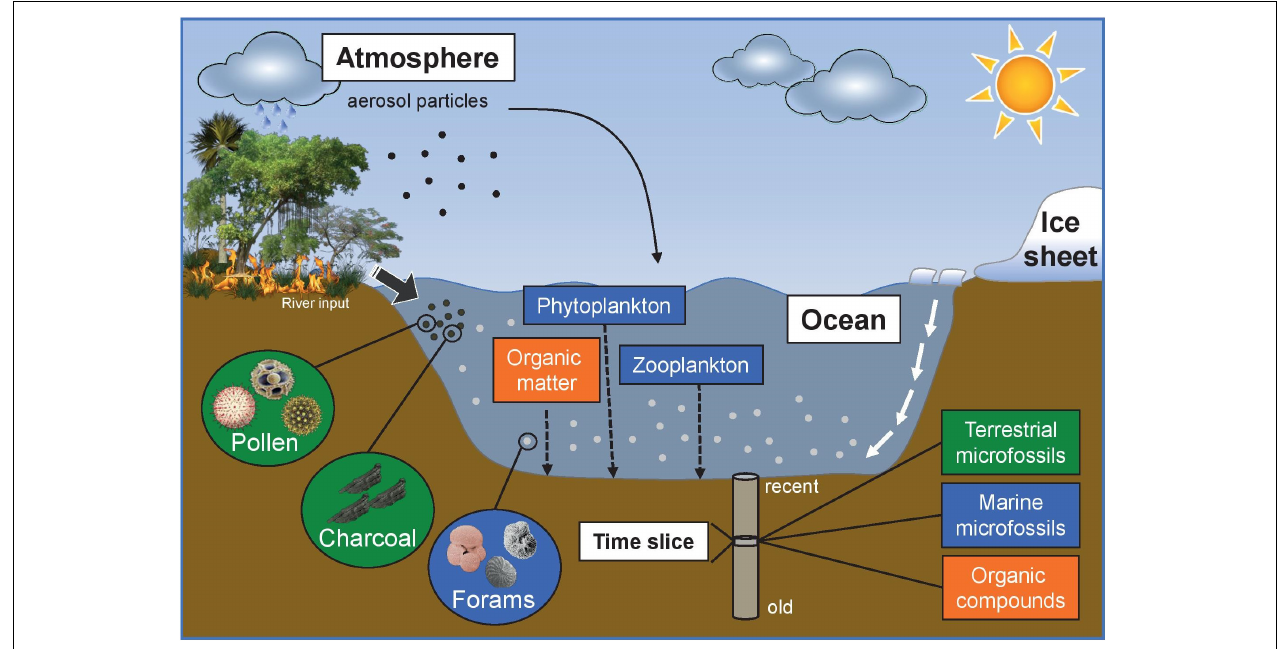
FIGURE 5 | Integrated approach using marine sedimentary sequences to unravel terrestrial and oceanic changes during abrupt climate events and pathways of terrestrial and marine microfossil deposition. Forams: foraminifera. Modified from Center for Advanced Marine Core Research, Kochi University. (2020) https://www.kochi-u.ac.jp/marine-core/research/.